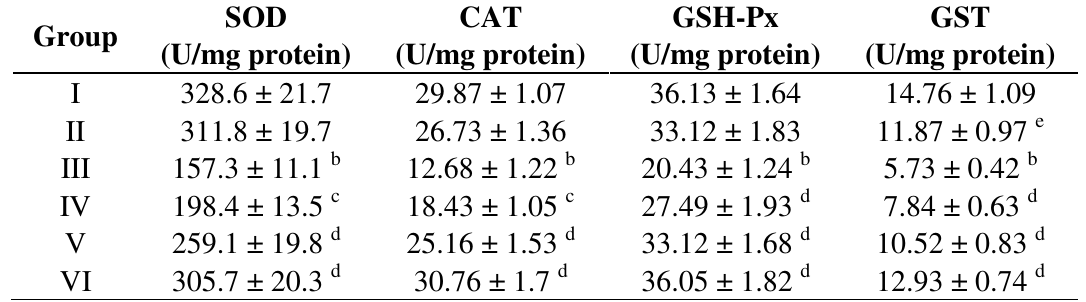
Table 6. Effect of GBE50 on myocardium SOD, CAT, GSH-Px and GST activities in